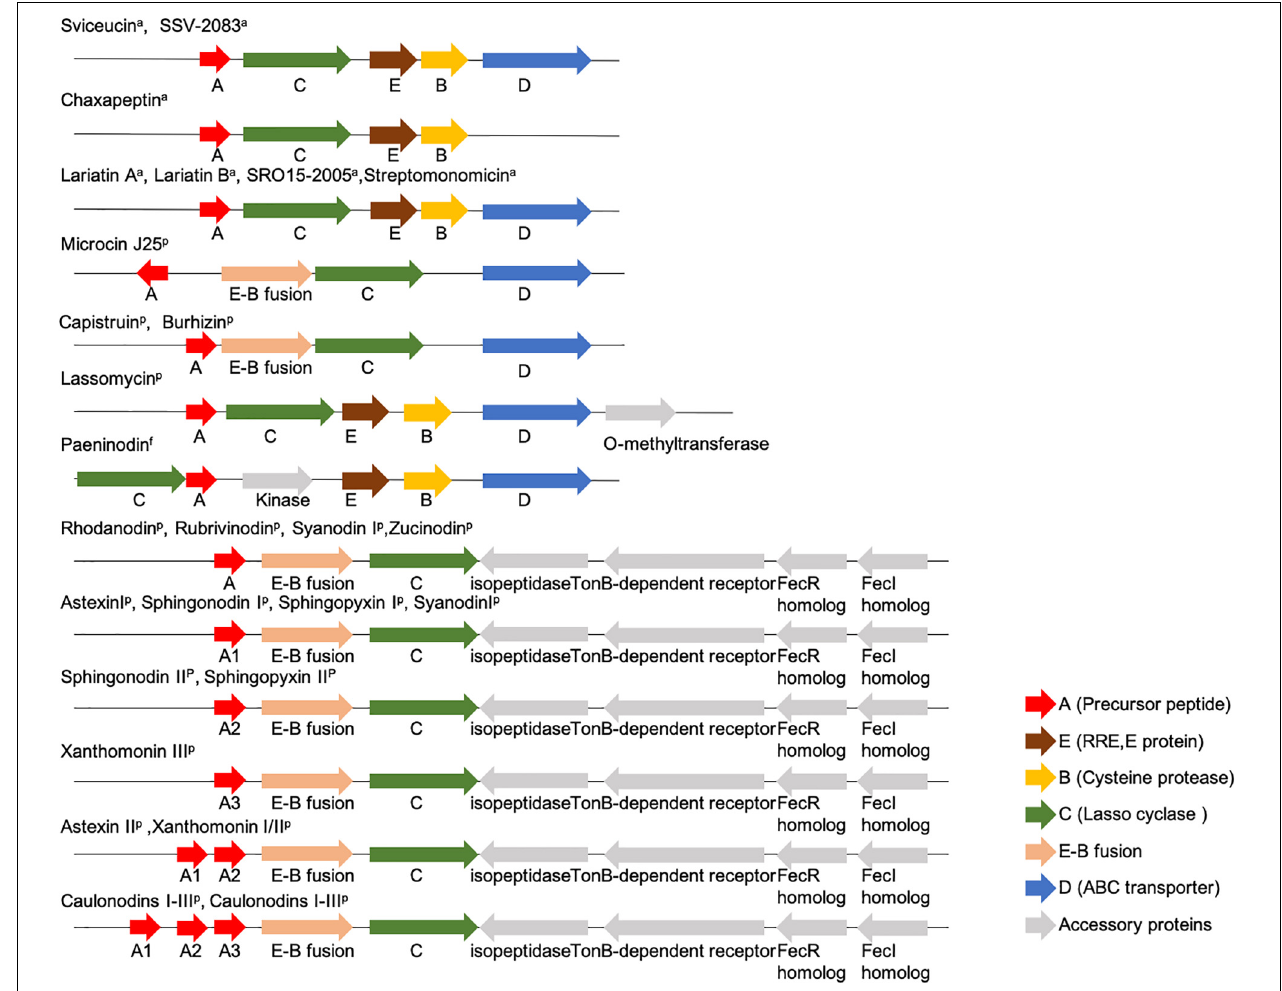
FIGURE 3 | Organization of commonly known lasso peptides from Actinobacteria , Proteobacteria , and Firmicutes (Solbiati et al., 1999; Knappe et al., 2008; Inokoshi et al., 2012; Maksimov et al., 2012b; Hegemann et al., 2013b, 2014; Maksimov and Link, 2013; Zimmermann et al., 2014; Zhu et al., 2016a; Kodani et al., 2018; Martin-Gomez et al., 2018; Su et al., 2019; Yu et al.,